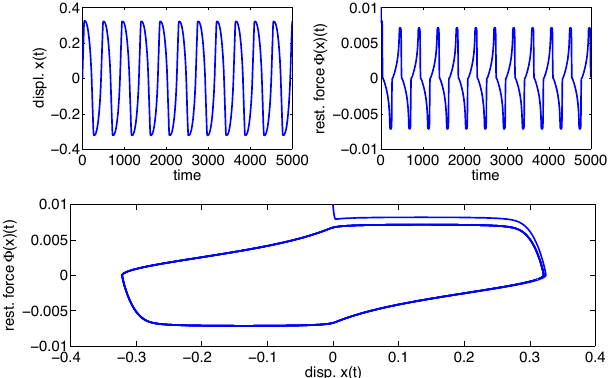
Figure 3. Limit cycles for a Class IV double-loop Bouc–Wen